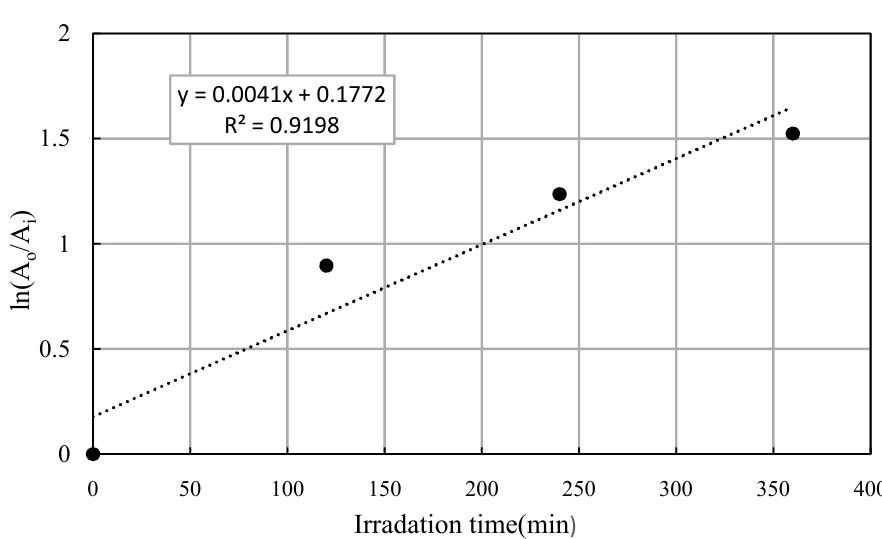
y = 0.0041x + 0.1772 R² = 0.9198